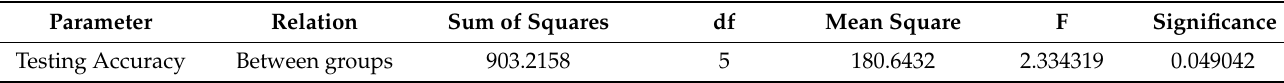
Table 2. One-way ANOVA result test of QRS with PSO